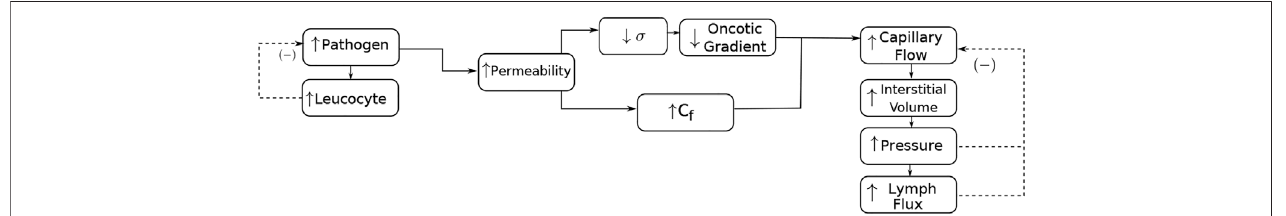
FIGURE1| Interactionofthespeciesandtheporoelasticdynamicsformodellinganin fl ammatoryoedemaformation.Theincreaseinthepathogenconcentrationis responsible for an increase in leukocyte concentration. Leukocytes start the production of cytokines (not shown in the fi gure), which increases the permeability of the endothelium. The increase in permeability is manifested by the reduction in the oncotic re fl ection coef fi cient ( σ ) and the increase in hydraulic conductivity ( C f ). The reductionintheoncoticre fl ectioncoef fi cientalsoreducestheoncoticgradient.Theincreaseinpermeabilityalsoincreasestheresulting fl uidinterstitialexchangeby blood capillaries (capillary fl ow), interstitial volume, pressure, and lymphatic fl ow. On the other hand, the increase in pressure and lymphatic fl ow results in negative feedback to the resulting capillary fl ow, tending to reduce it. The increase in leukocytes tends to reduce the presence of